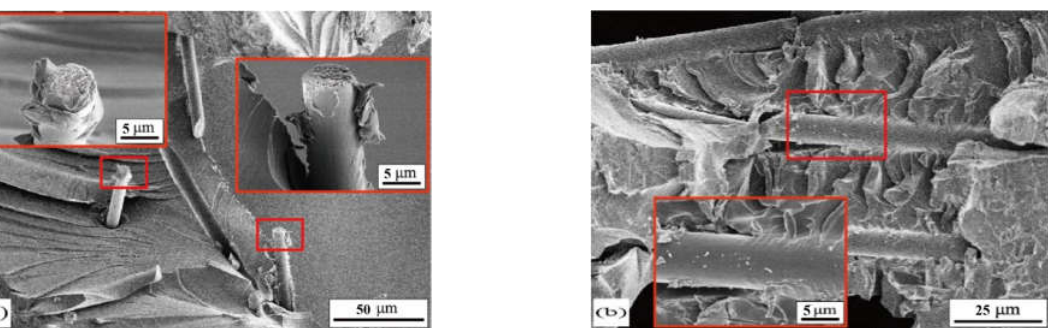
Figure 14. Fracture surfaces of unreinforced SLJ (Group A, pure adhesive) with (a)panel, (b) the perforated aluminum block and reinforced SLJ (Group E, 0.2%wt & 3 mm CF) with (c)panel, (d)the perforated aluminum block